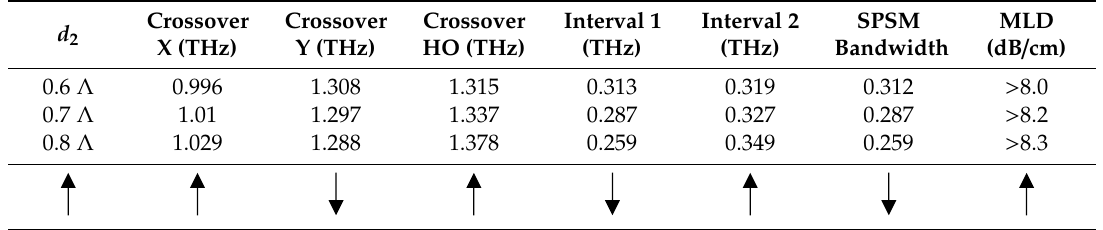
Table 3. Crossover points, interval size, SPSM bandwidth, and MLD values for di ff erent air hole diameters ( d 2 ).